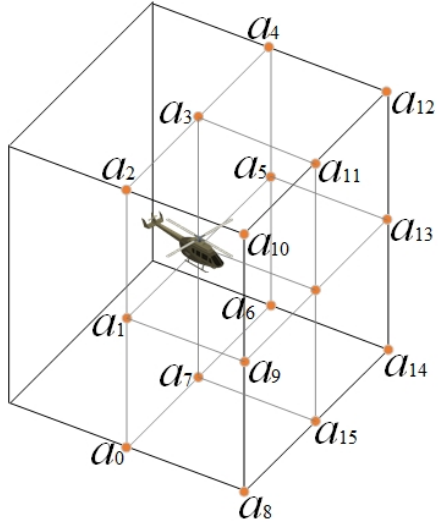
Figure 2. Movement of unmanned helicopters.